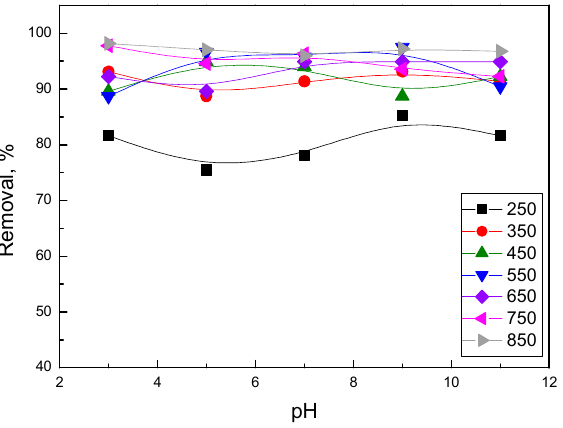
Figure 6. Mercury removal rate of activated biochars in different pH environments.